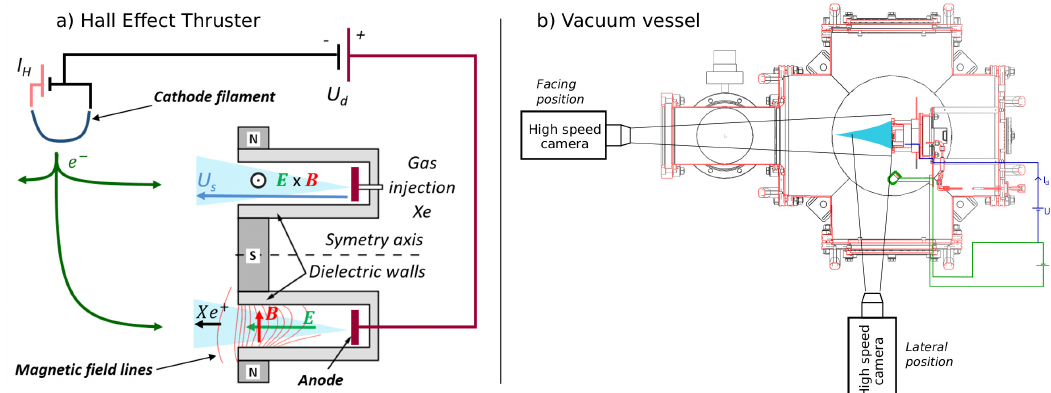
Figure 1. Schematics of: ( a ) a HET side view, with relevant parameters: discharge voltage U d , discharge current I d , cathode heating current I H and potential difference between the anode and the plume U S ; and ( b ) an experimental vacuum chamber with the two camera